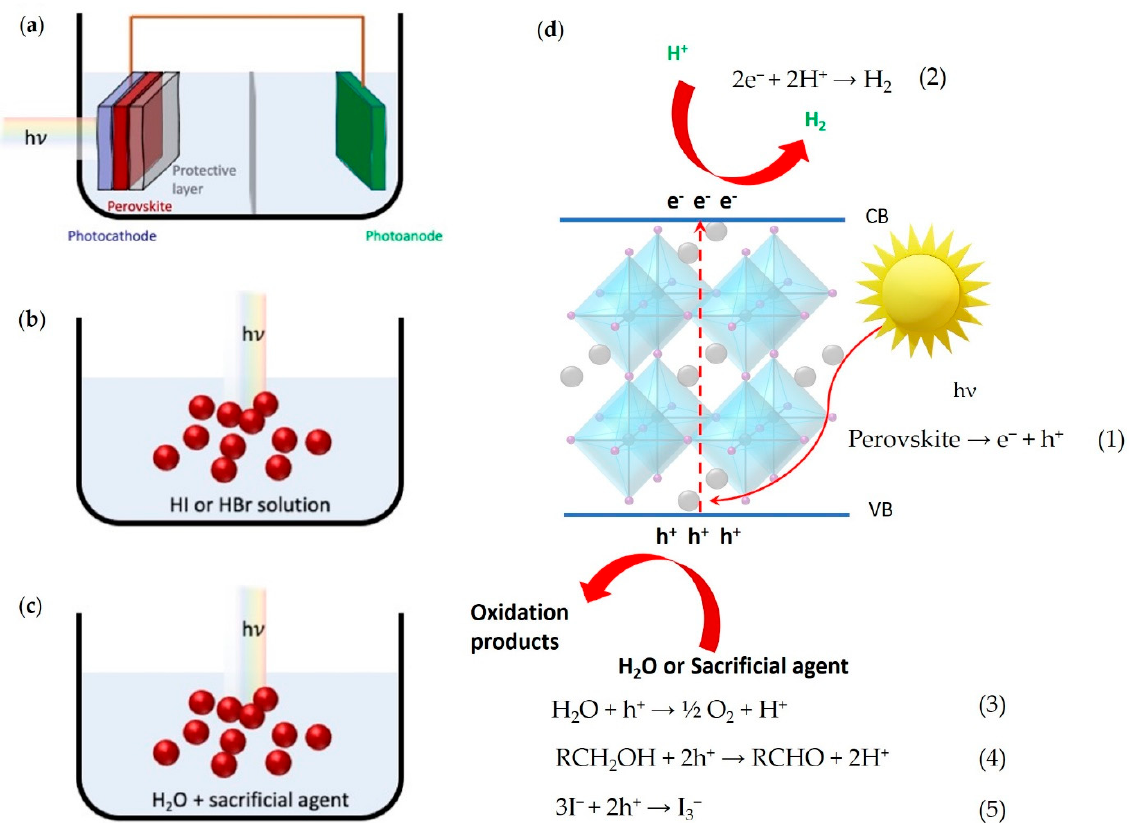
Figure 1. Solar-driven perovskite-based H 2 production systems: ( a ) photoelectrochemical (PEC) cell; ( b ) particulate photocatalyst system in dynamic equilibrium; ( c ) particulate water-stable photocatalyst system. ( d ) Schematic representation of the processes on the perovskite photocatalyst surface under irradiation and possible reactions involved in the different systems (Equations (1)–(5)).